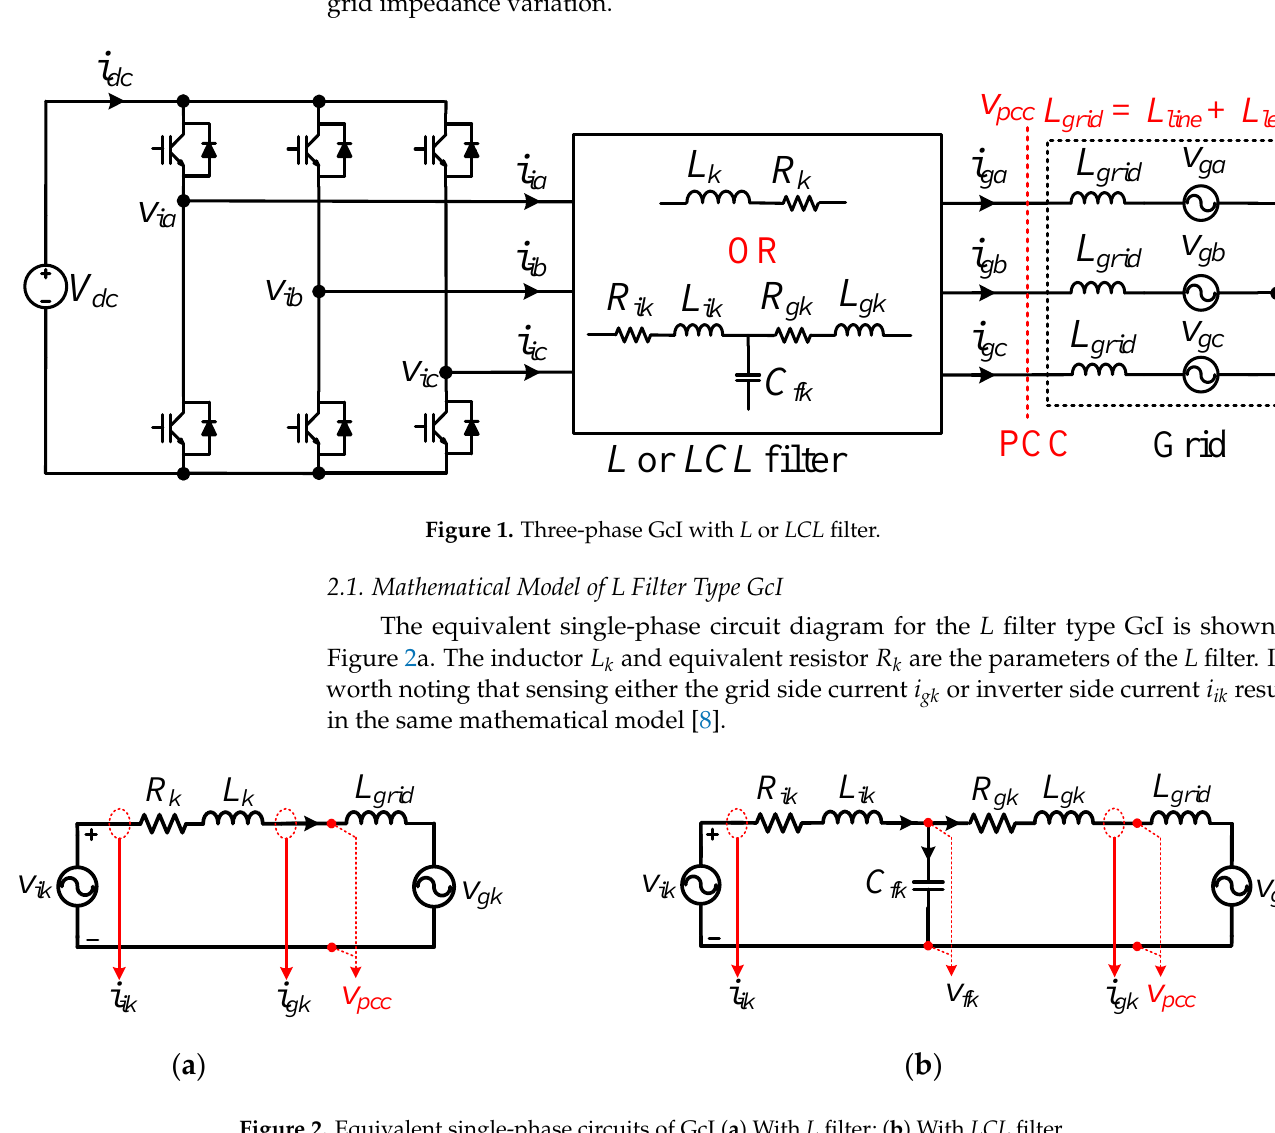
Figure 2. Equivalent single-phase circuits of GcI ( a ) With L filter; ( b ) With LCL filter.